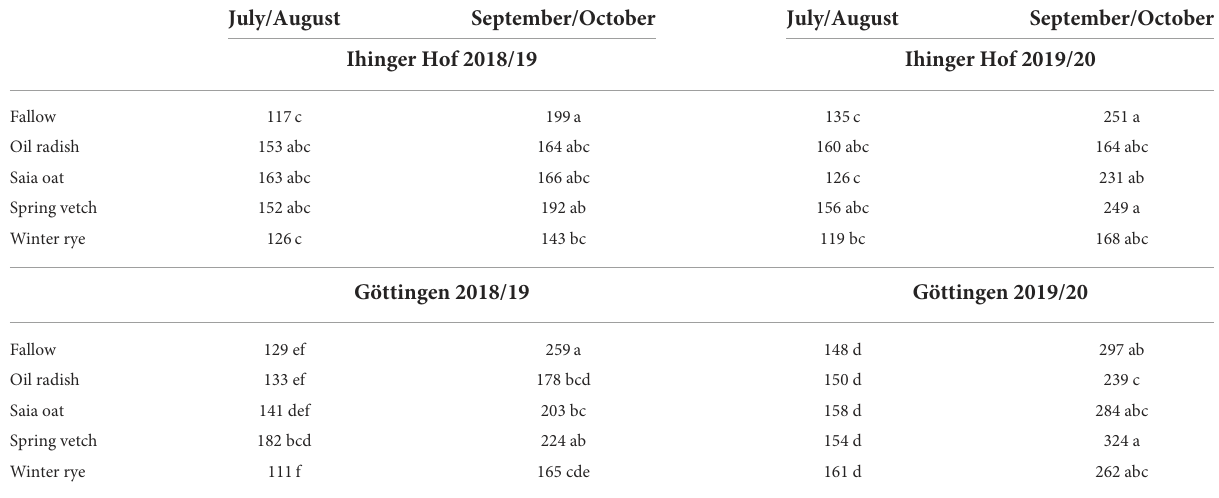
TABLE 3 N content of unfertilized sugar beet (kg N ha − 1 ) after different cover crop treatments at two dates of the growing season at Ihinger Hof 2018/19 and 2019/20, and Göttingen 2018/19 and 2019/20.